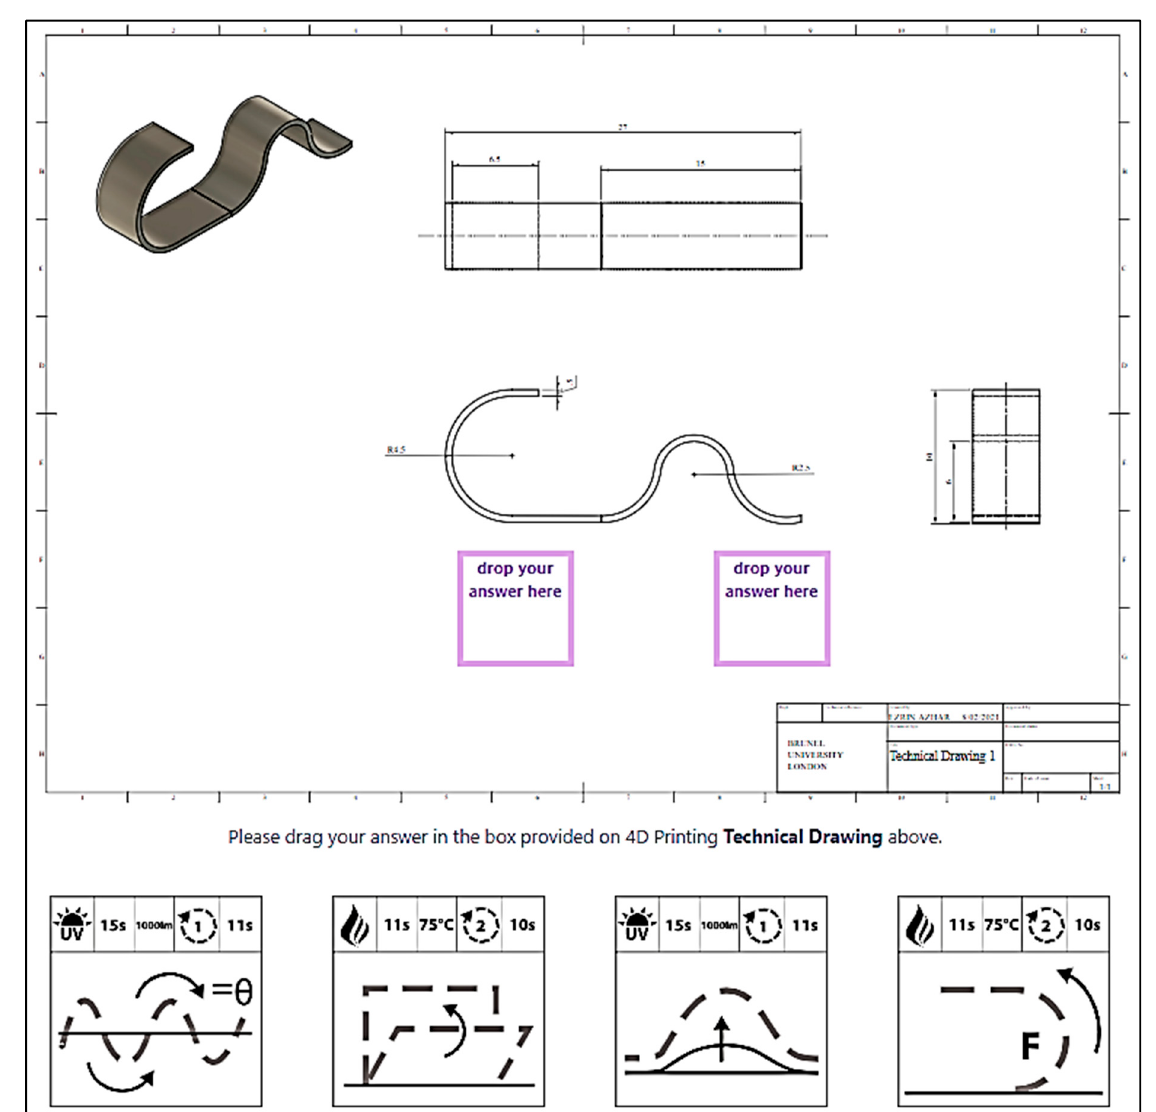
Figure 6. A task designed for the